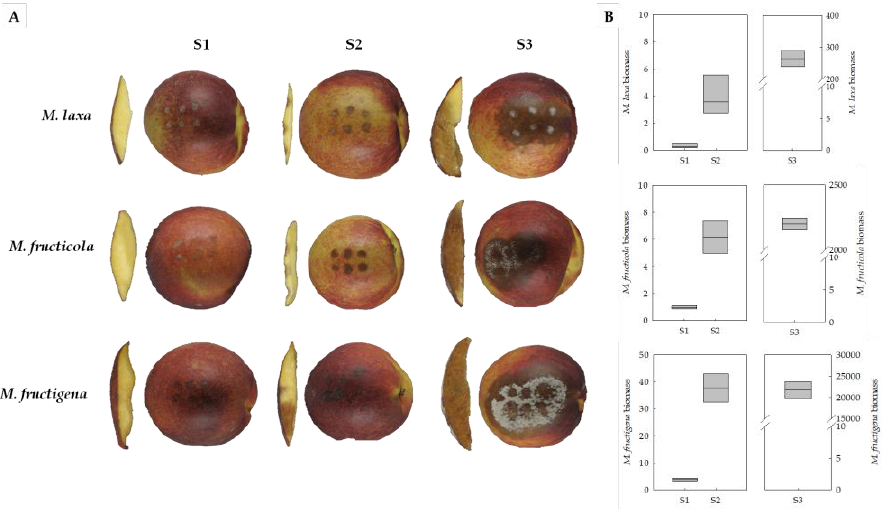
Figure 3. Brown rot spread in ’Red Jim’ nectarines at different stages after inoculation: peel surface maceration stage (S1), colonization of the pathogen (S2), and spreading stage (S3). ( A ) Two different viewpoints are shown (left image: perpendicular section of the fruit to discern fungal colonization if observable; right image: entire fruit showing 6 drops). ( B ) Determination of pathogenic biomass by relative gene expression of the reference gene of Monilinia spp. ( EF1- α ), normalized to the expression of the reference gene of nectarine ( TEF2 ) for each Monilinia spp. The box plot represents the mean of three biological replicates with their interquartile